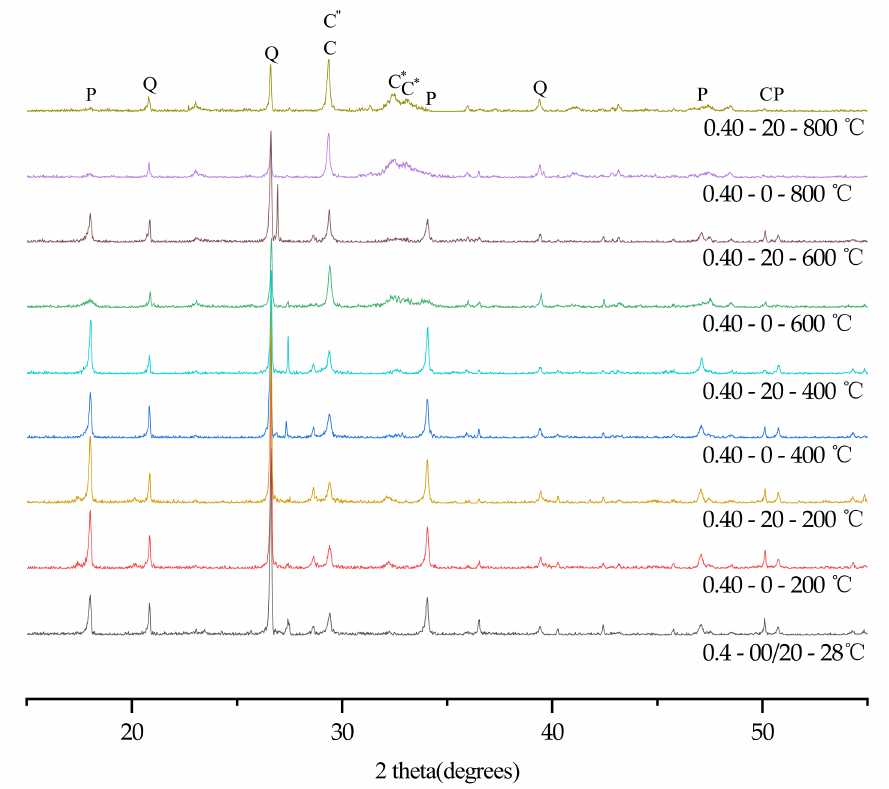
Figure 5. X-ray diffractograms of concrete (W/C = 0.40). Keys to phases: P (Portlandite); Q (Quartz); C (C-S-H gel); C” (Calcite); C* (Calcium silicate). 3.7.